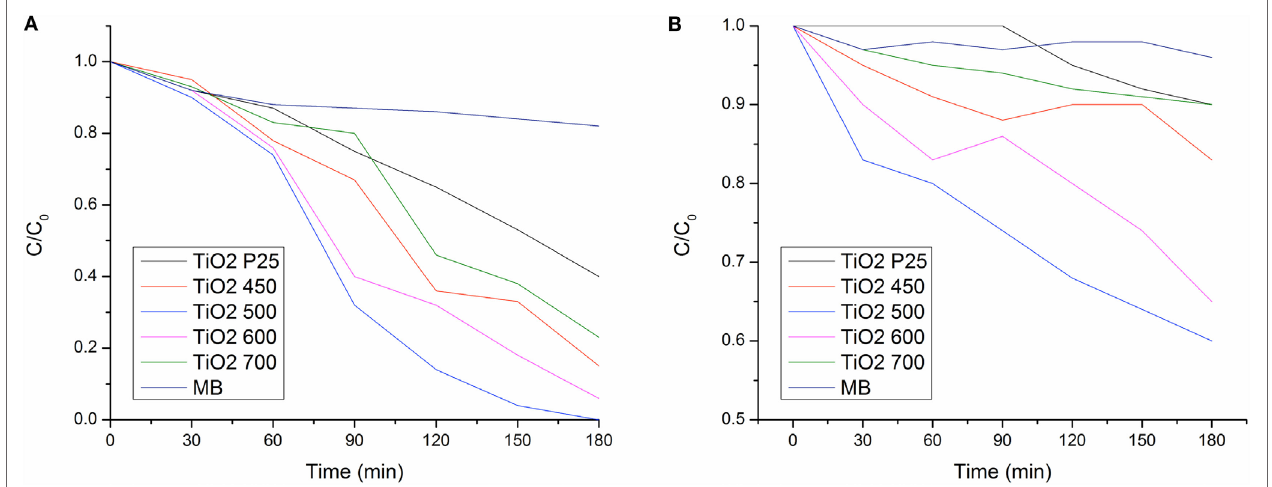
FigUre 9 | Photodegradation of MB under (a) UV-visible light and (B) visible spectrum ( λ > 400 nm) of TiO 2 nanofibers annealed at 450, 500, 600, and 700°c